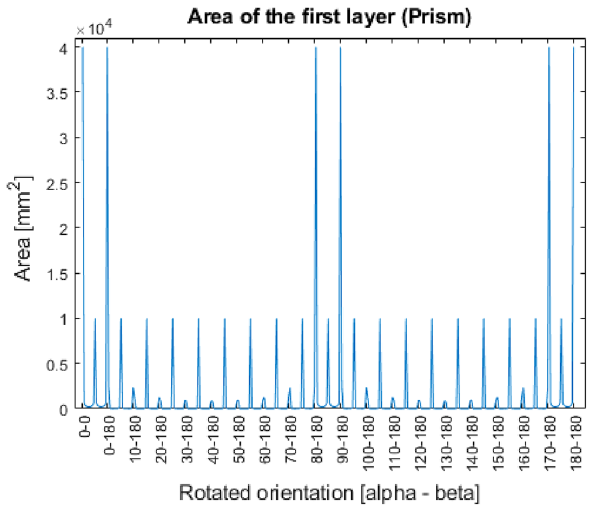
Figure 9. Area of the first layer